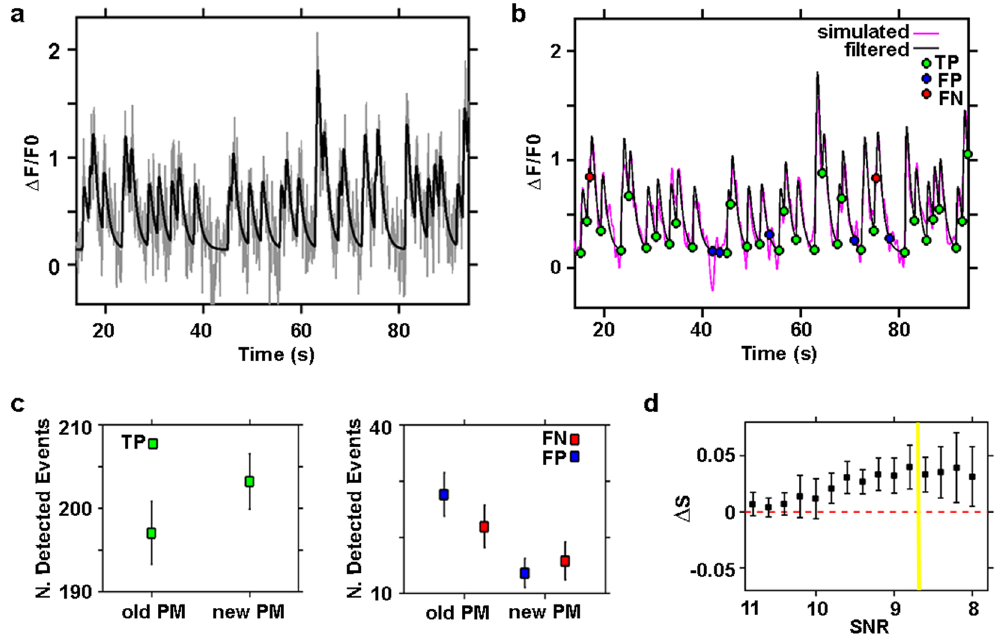
Figure 3. Detection efficiency of the novel Perona-Malik filter. ( a ) Simulated neuronal calcium trace (black line) with added noise (gray line), SNR = 9; ( b ) Simulated neuronal calcium trace (black line) shown in ( a ), with superimposed filtered trace (magenta line) obtained from the trace with added noise (gray line) shown in panel (a). The green, blue and red circles indicate the onset time of true (TP) and false (FP) detected events, and the onset time of non-detected events (FN) respectively, through the novel Perona-Malik filter; ( c ) quantification of the classical Perona-Malik filter (old PM) and novel Perona-Malik filter (new PM) performance in detecting true calcium events (TP) on left panel. On the right panel, comparison of the two filters in missing true events (FN) and detecting false events (FP). The quantification of the performance of the filters was done on 30 simulated traces with SNR = 9. Data are shown as mean ± std (n = 30 simulated traces); ( d ) Comparison of the two filter sensitivity, quantified as sensitivity difference ( Δ S), with respect to decreasing levels of signal to noise ratio (SNR). The sensitivity S of the filters was computed as the ratio between the number of detected true events (TP) divided by the total number of events within the traces (TP + FN). Data are shown as mean ± std (n = 30 simulated traces for each SNR